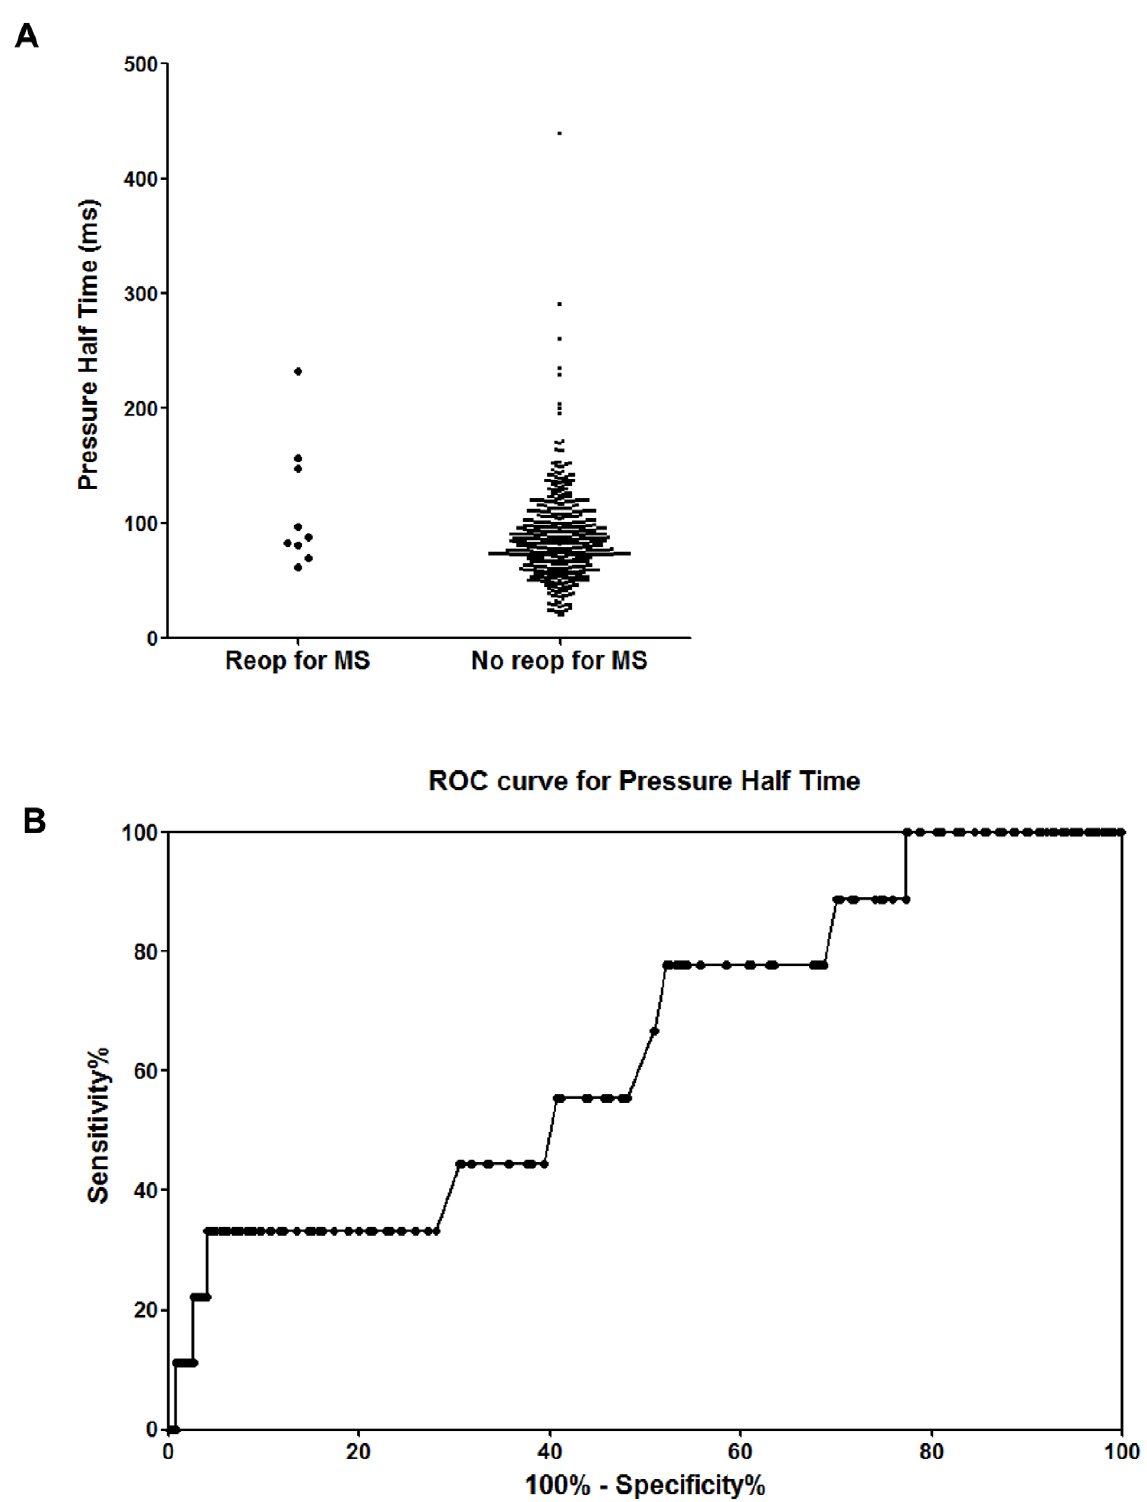
Figure 3. Distribution of pressure half times after mitral valve repair. (A) Distribution of pressure half times showed no significant difference in distribution between cases requiring reoperation for MS and those that did not. (B) Receiver operator curve (ROC) for pressure half time (PHT). The area under the curve (AUC [SE]) showed only weak discriminating ability (0.640 [0.092]).